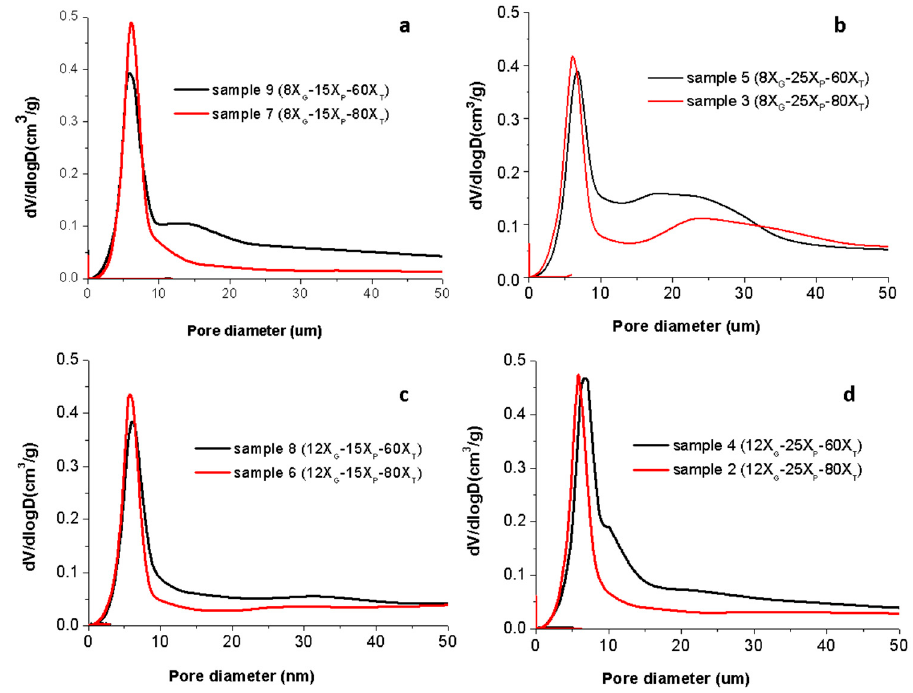
Figure 5. Pore distributions by Mercury Intrusion Porosimetry (MIP), for samples in Table S1. Grouping operational variables by fixing X G and X P and variable X T : ( a ) sample 9 (8X G − 15X P − 60X T ) and sample 7 (8X G − 15X P − 80X T ); ( b ) sample 5 (8X G − 25X P − 60X T ) and sample 3 (8X G − 25X P − 80X T ); ( c ) sample 8 (12X G − 15X P − 60X T ) and sample 6 (12X G − 15X P − 80X T ); ( d ) sample 4 (12X G − 25X P − 60X T ) and sample 2 (12X G − 25X P − 80X T ).